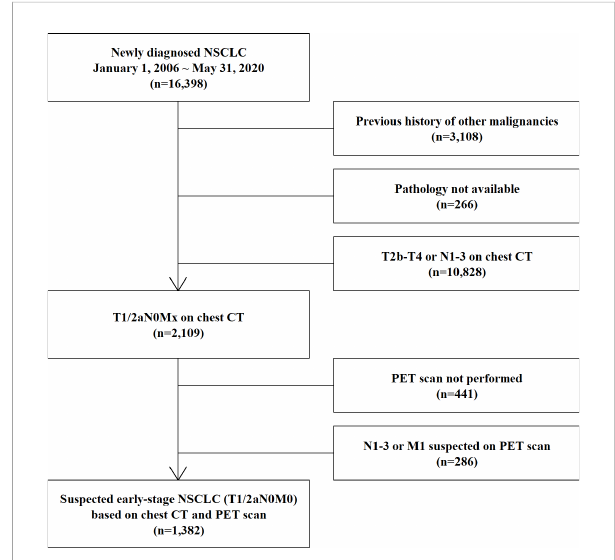
FIGURE 1 Process of selection of the study population. NSCLC, non-small-cell lung cancer; CT, computed tomography; PET, positron emission tomography; MRI, magnetic resonance